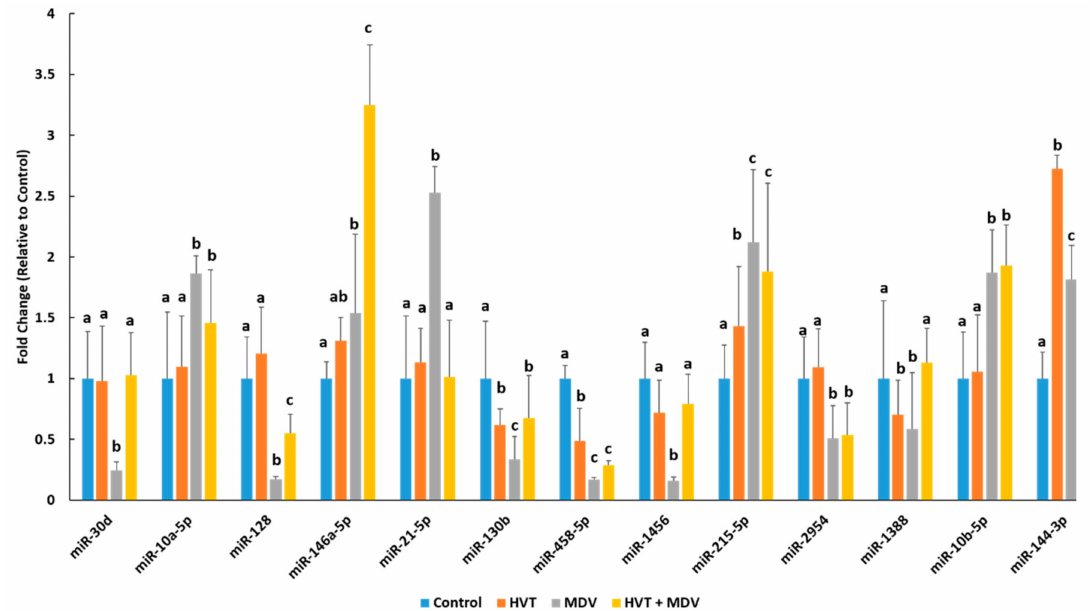
Figure 1. Cellular miRNA splenic expression profiles in uninfected, Herpesvirus of Turkeys (HVT) vaccinated, MDV infected, or HVT + MDV co-infected SPF (specific-pathogen-free) chickens. The splenic expression profile of 13 differentially expressed miRNAs was determined in control (mock-infected) birds ( n = 4), HVT-vaccinated birds ( n = 4), MDV-infected birds ( n = 4), and birds vaccinated with HVT and subsequently infected with MDV ( n = 4) at 42dpi using RT-qPCR. Error bars denote standard deviations. Differing letters denote statistical significance ( p < 0.05). For each miRNA, treatment groups with differing letters had a statistically significant difference ( p < 0.05), while groups with the same letter were not significantly different ( p >